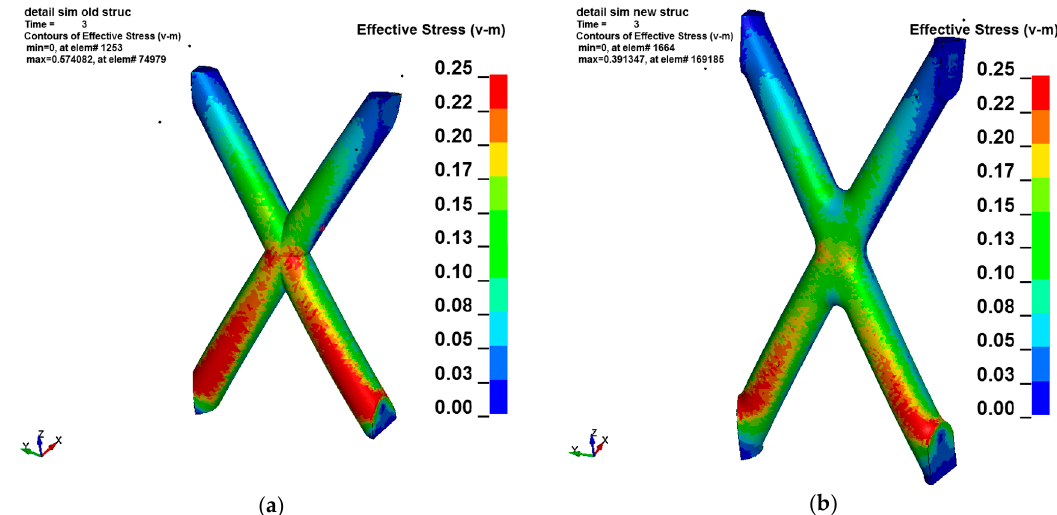
Figure 15. Detailed model of unit cell with equivalent von Mises stress distribution: initial geometry ( a ) and improved geometry ( b ).